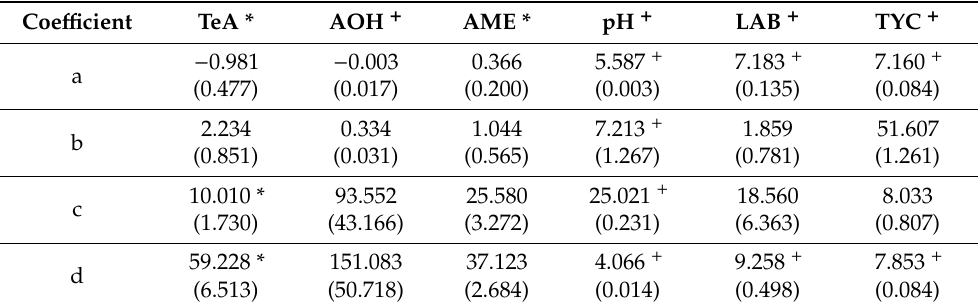
Table 3. Regression coe ffi cients in tenuazonic acid (TeA), alternariol (AOH) and alternariol monomethyl ether (AME) reduction models and pH value, total lactic acid bacteria (LAB) and total yeast count prediction